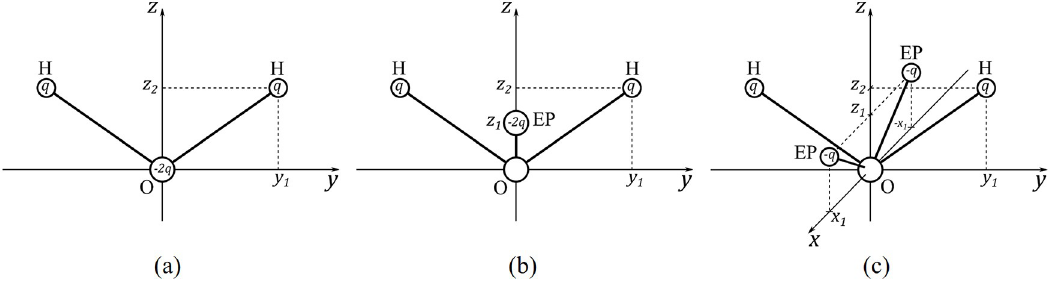
Fig 3. Schematics of 3, 4 and 5-point rigid water models. Each circle represents an interaction point (H, O atom, or extra point– EP). Thick lines are chemical bonds. The origin point is on the Oxygen; C 2 symmetry axis of water is set as the z-axis; y-axis is in the H-O-H plane and passes through O; x-direction is only accounted for in a 5-point model, and the 2 extra interaction points (EP) are placed on the xOz plane. Electric charge on H is q , charge − 2 q is placed on O for 3-point model, on EP for 4-point model, and divided evenly on the two EPs for 5-point model. (a) 3-point water model. (b) 4-point water model. (c) 5-point water model.